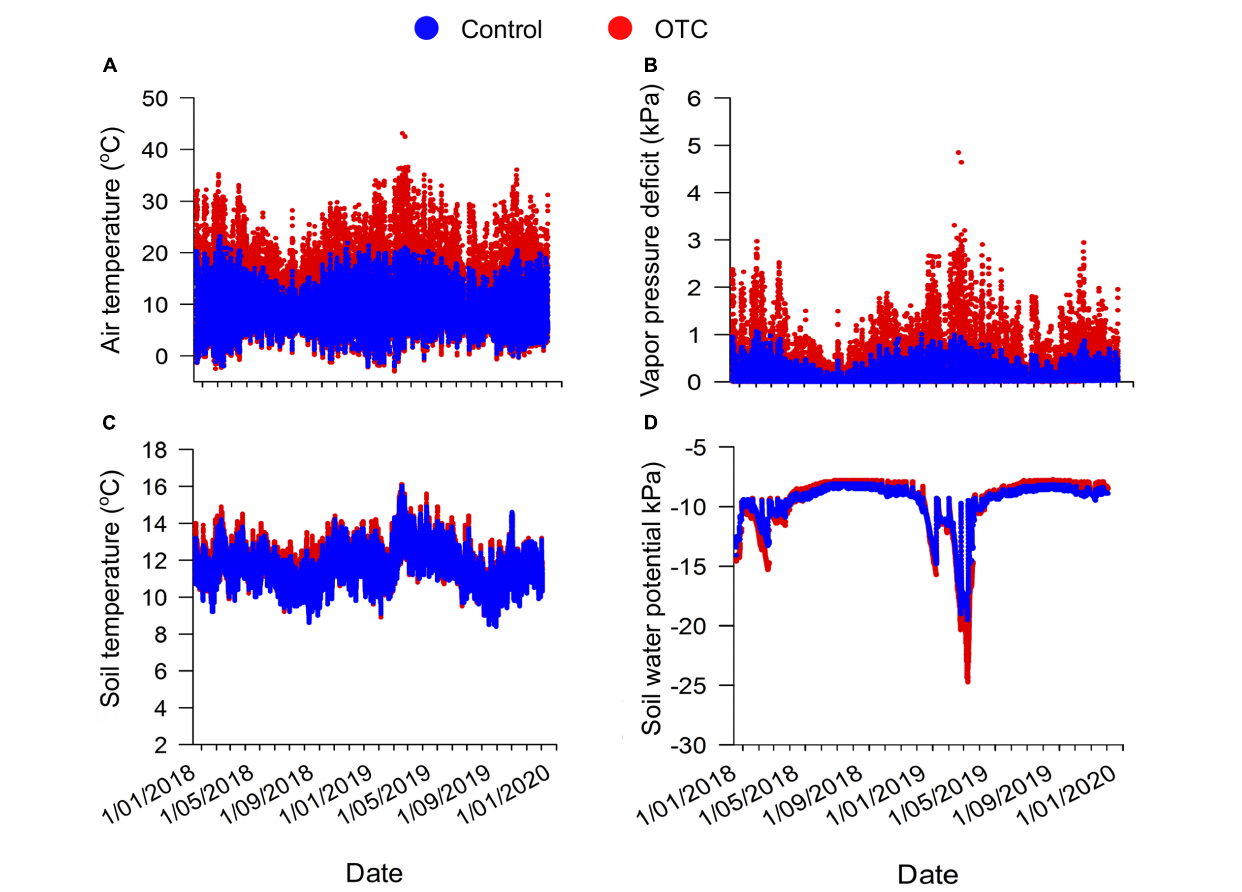
FIGURE 2 | Climatic variables collected inside the OTC (red) and outside the OTC (blue). Air temperature (A) , air vapor pressure deficit (B) , soil temperature (C) , and soil water potential (D) were collected every 30 min starting on December 19, 2017 until December 3, 2019 in